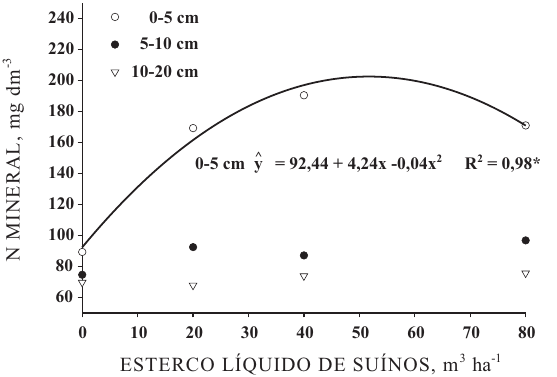
Figura 3. Teores de N mineral no solo, aos 156 dias após emergência da mistura forrageira de aveia mais azevém, em função de doses crescentes de esterco líquido de suínos e profundidade de amostragem.